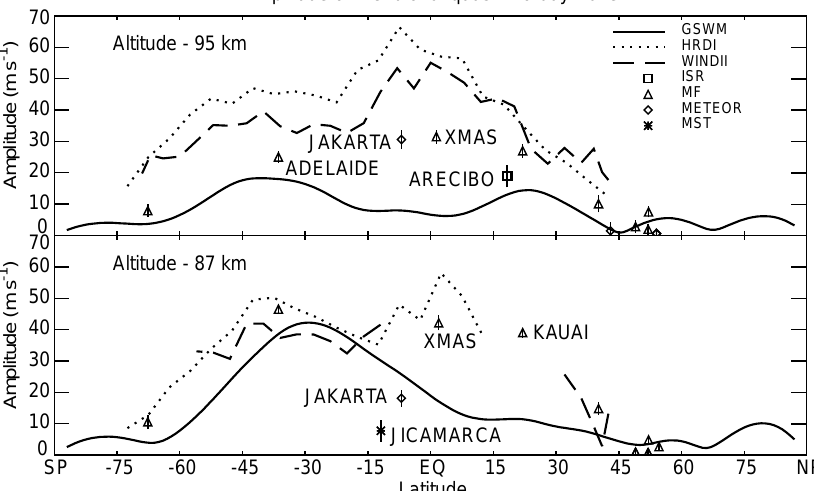
Fig. 14. An altitude cross section of the meridional quasi-two-day wave at 95 km ( top ) and 87 km ( bottom ). The key is the same as the amplitude key for